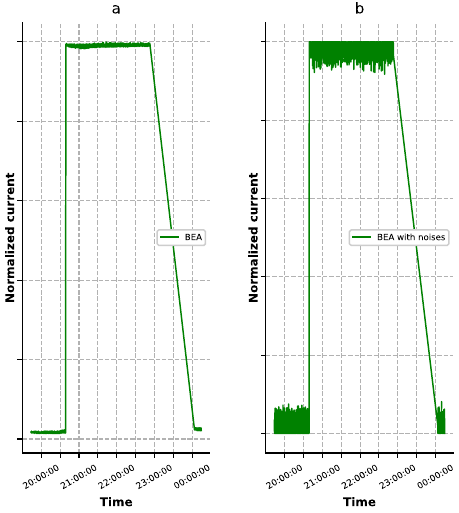
Figure 6. Comparison of the original BEA value with the BEA value with Gaussian noise. ( a ) The BEA value. ( b ) The BEA value with Gaussian noise.